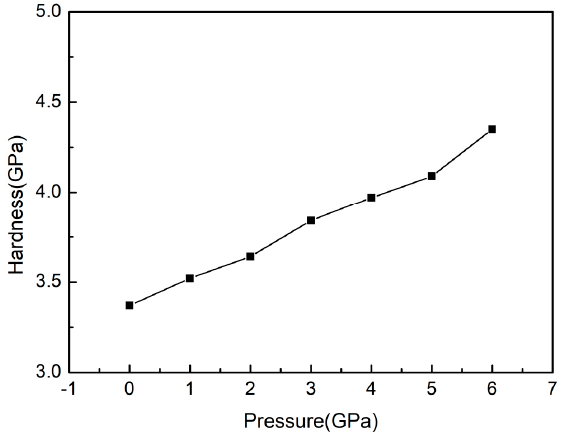
Figure 7. Hardness value of the Mg 23 Al 30 mesophase under pressure.